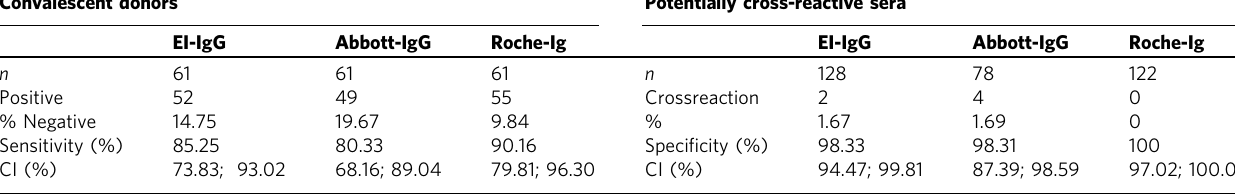
Table 2 Assay performance: calculation of the sensitivities with sera from convalescent donors and speci fi cities based on the individual assay performances in